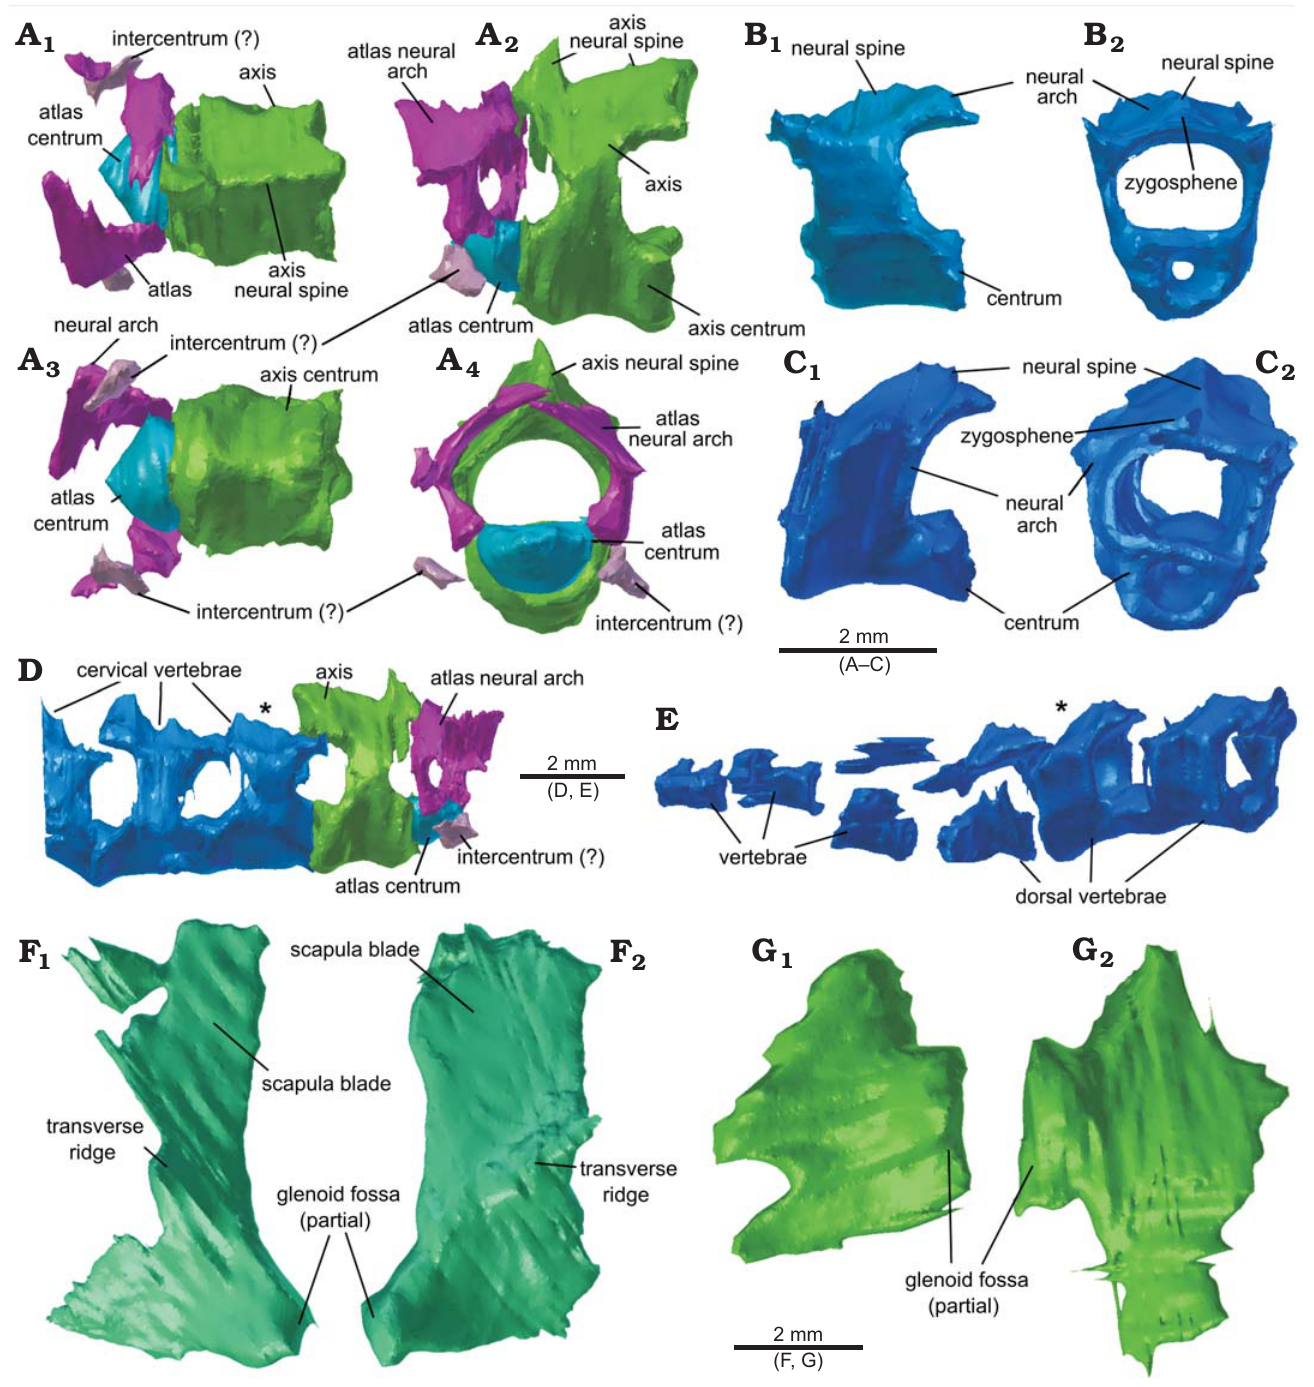
Fig. 11. The vertebral column and pectoral girdle elements of lepidosaur rynchocephalian Clevosaurus cambrica Keeble, Whiteside, and Benton, 2018 (NHMUK PV R37013 and NHMUK PV R37014) from Late Triassic, Pant-y-ffynnon, Wales, UK. A . The axial-atlas complex in dorsal (A 1 ), lateral (A 2 ), ventral (A 3 ) and anterior (A 4 ) views. B . The third cervical vertebra in right lateral (B 1 ) and anterior (B 2 ) views. C . A dorsal vertebra in right lateral (C 1 ) and anterior (C 2 ) views. D . The five cervical vertebrae present in the scans taken of NHMUK PV R37014, in lateral view, with asterisk indicating the cervical vertebra seen in B; note the posterior-most vertebra terminates prematurely due to the extent of the CT scans. E . The partial vertebral column of NHMUK PV R37013 in lateral view, with asterisk indicating the dorsal vertebra seen in C. F . The left (F 1 ) and right (F 2 ) scapula in lateral view. G . The left (G 1 ) and right (G 2 ) coracoids in lateral